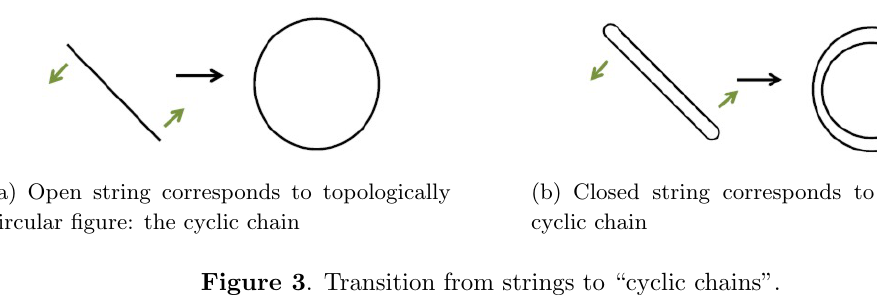
Figure 3 . Transition from strings to \cyclic